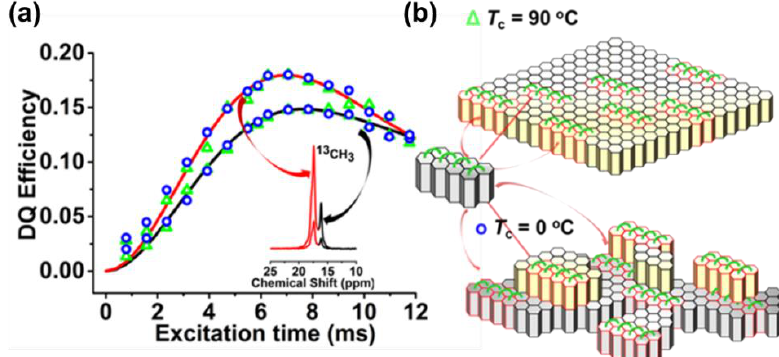
Figure 8. ( a ) 13 C – 13 C DQ buildup curve for 13 C CH 3 -enriched PLLA single crystal blends with non-labeled chains crystallized ( a ) in 0.05 wt% amino acetate solution at 90 ◦ C (green open triangles) and ~0 ◦ C (blue open circles). The solid curves with < n > = 7 and < F > = 100% in two layers represents best-fit curves with experimental data. ( b ) Schematic illustration of nano building blocks of eight stem clusters in solution grown crystals at T c = 90 and ~0 ◦ C. (Reprinted with permission from Macromolecules 2017 , 50 , 6404 – 6414.Copyright (2017) American Chemical Society).